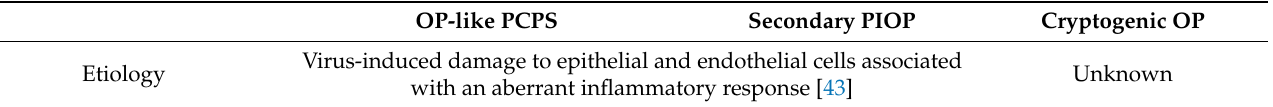
Table 1. Etiology, pathogenesis, and clinical manifestation of OP-like PCPS, PIOP, and cryptogenic